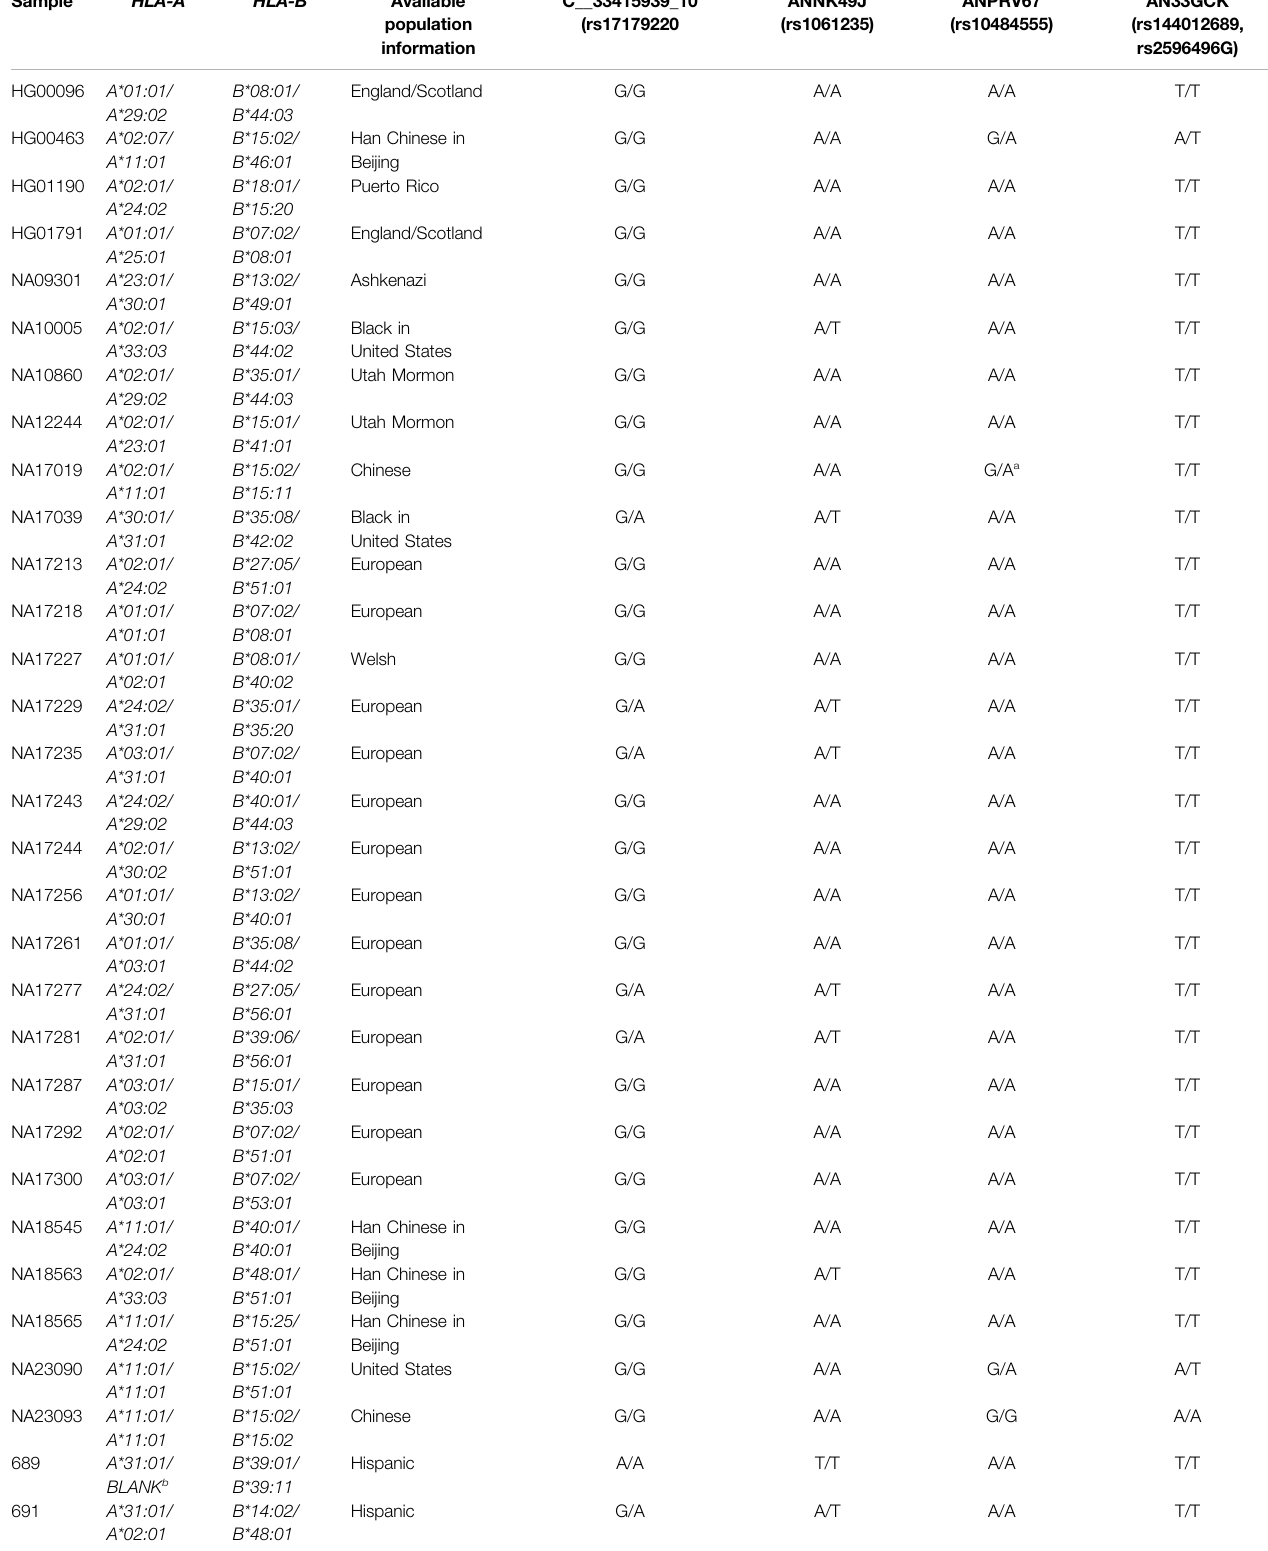
TABLE 4 | Reference sample prior haplotype data and TaqMan assay results.